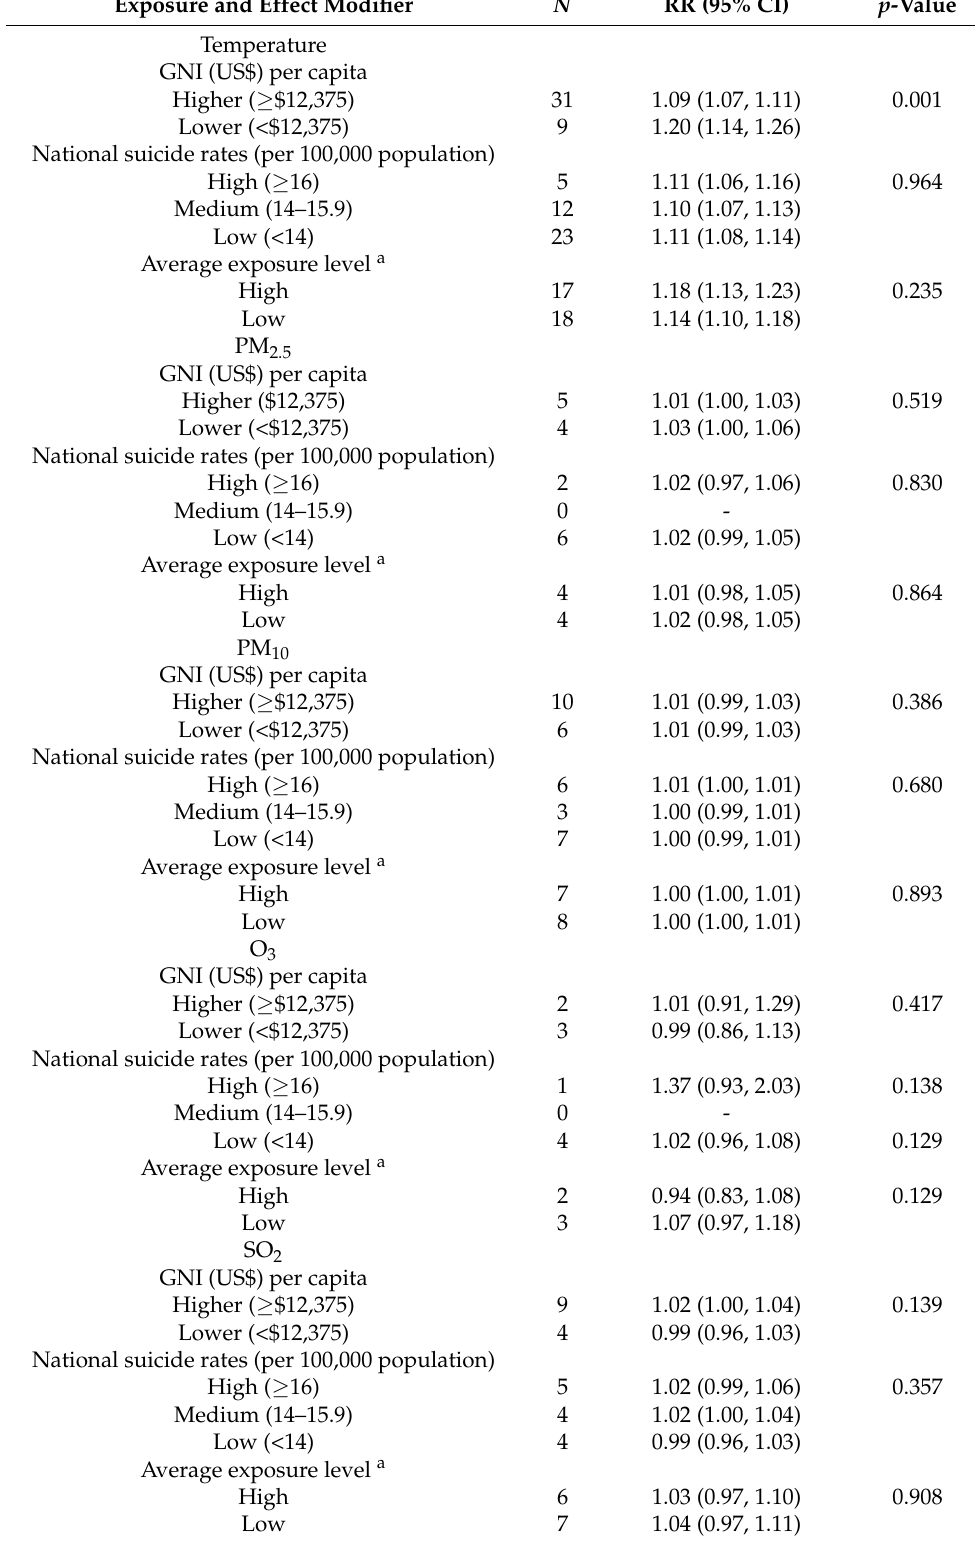
Table 4. Relative risks (RRs) of suicide associated with an interquartile range increase in temperature, PM 2.5 , PM 10 , and O 3 , SO 2 , NO 2 , and CO by GNI per capita, national suicide rates, and average exposure